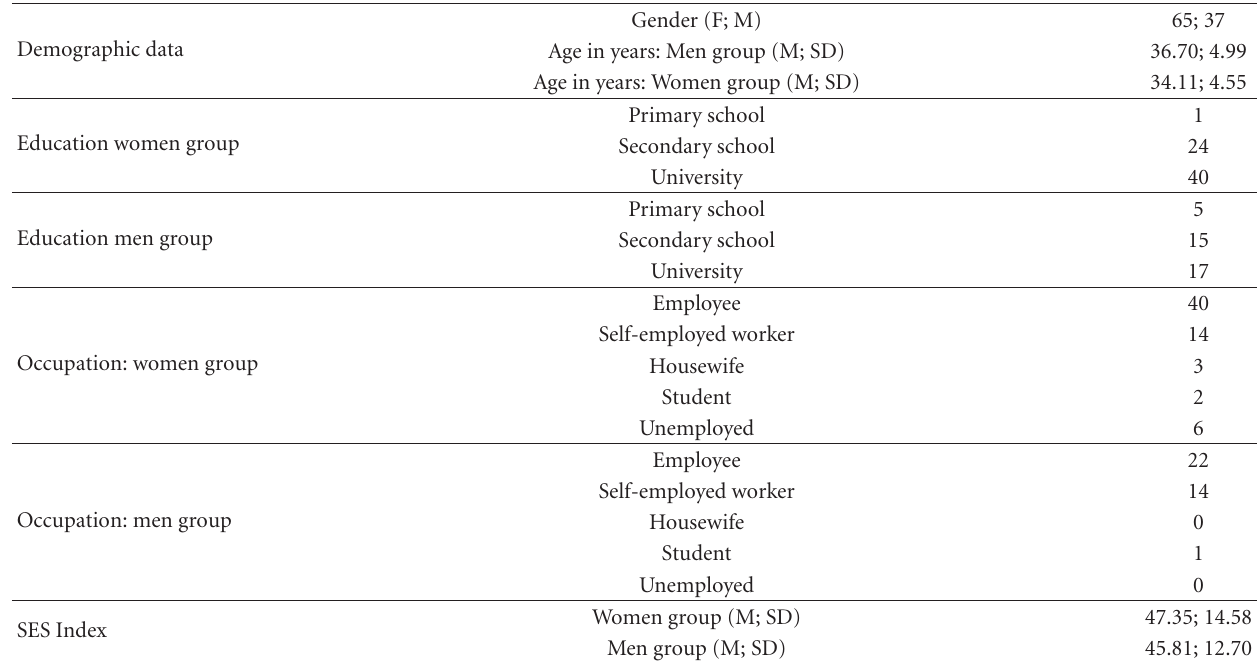
Table 1: Characteristics of